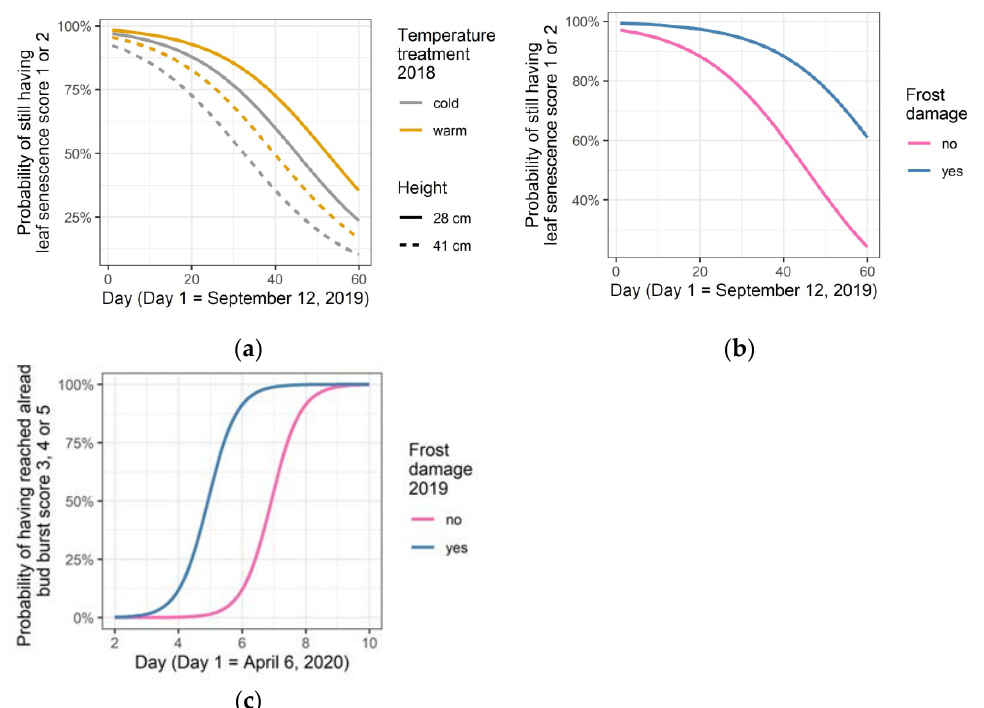
Figure 9. Modelled probabilities of having reached the given score levels for leaf senescence in 2019 ( a , b ) and for bud burst in 2020 ( c ). The probabilities depend on the temperature treatment in the spring of 2018 ( a ) and on the late spring frost in 2019 ( b , c ). Leaf senescence depends on the height of the plants (model fit in ( a ) for lower and upper